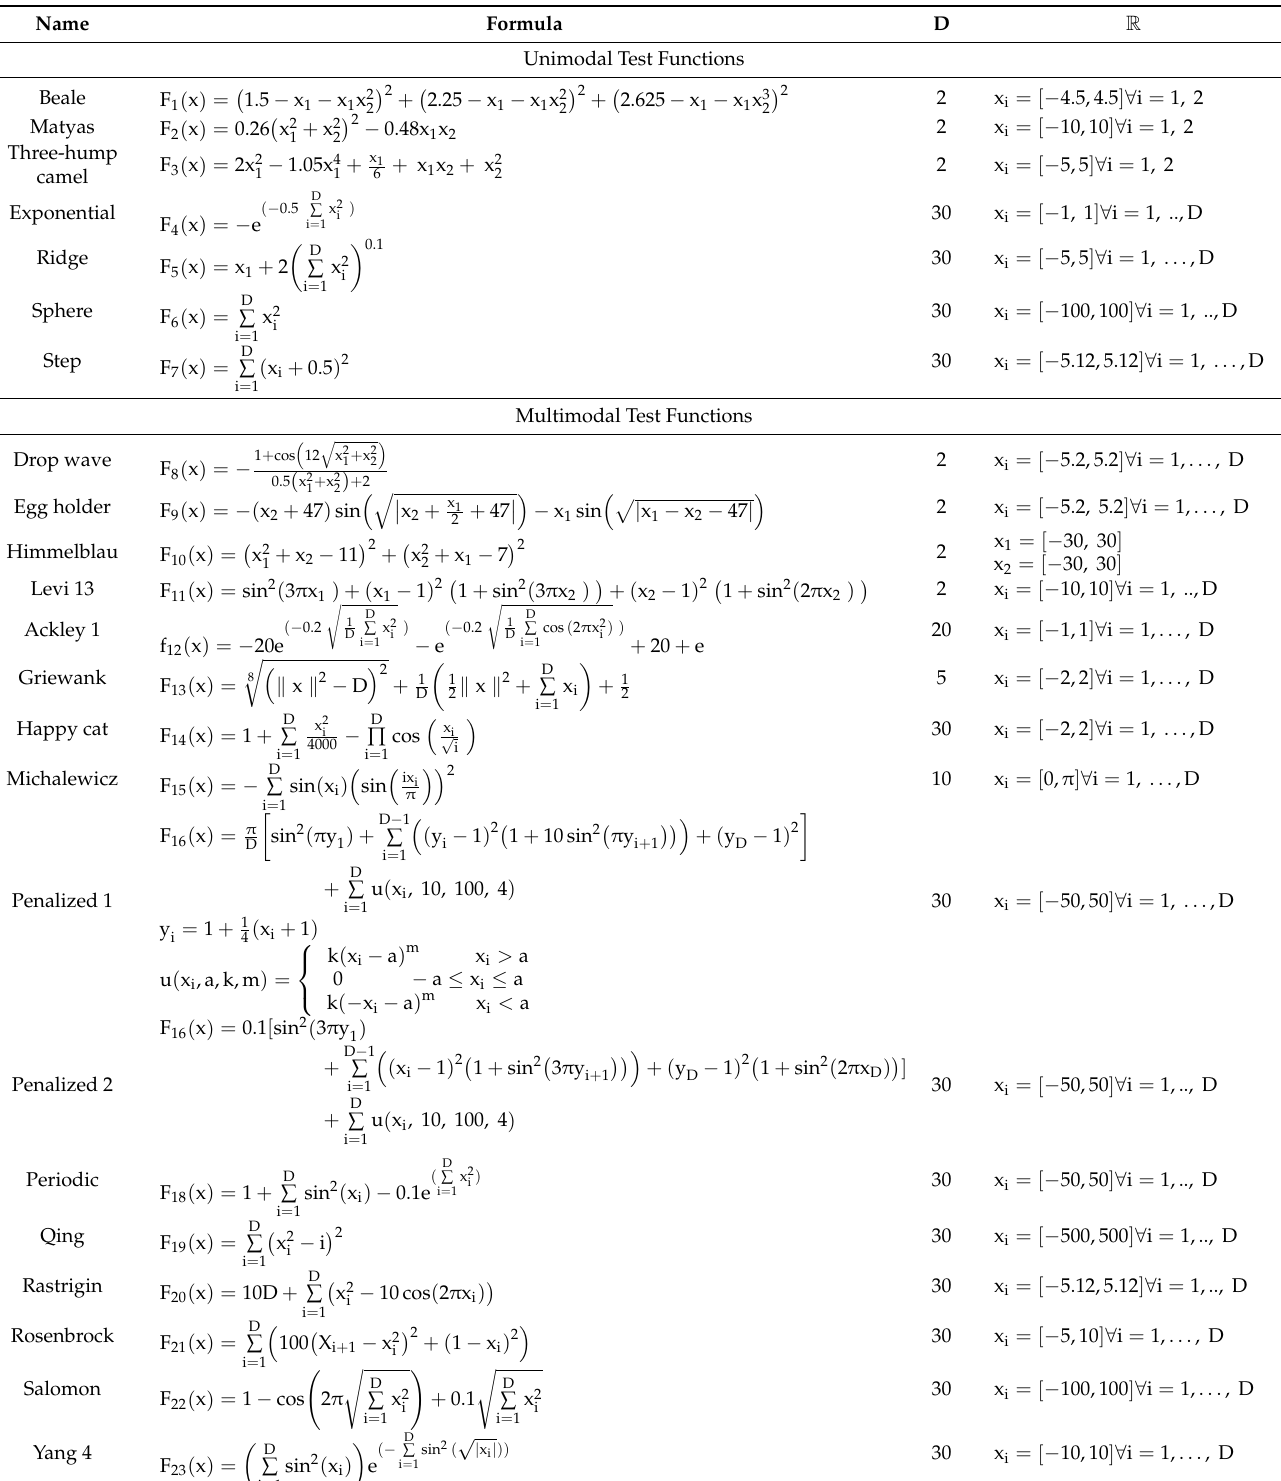
Table 1. Descriptions of benchmark test